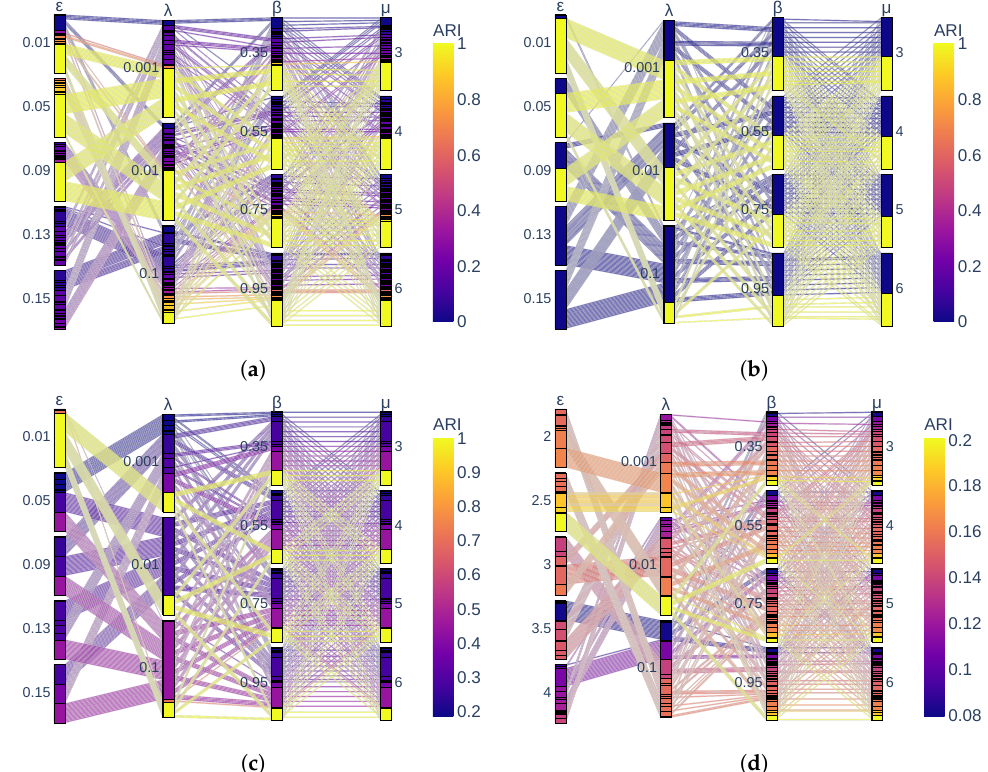
Figure 17. Variation of DenStream hyperparameters and ARI metric values. ( a ) Clustering with the Horseshoe dataset; ( b ) Clustering with the T dataset; ( c ) Clustering with the Moon dataset; ( d ) Clustering with the Three Spirals